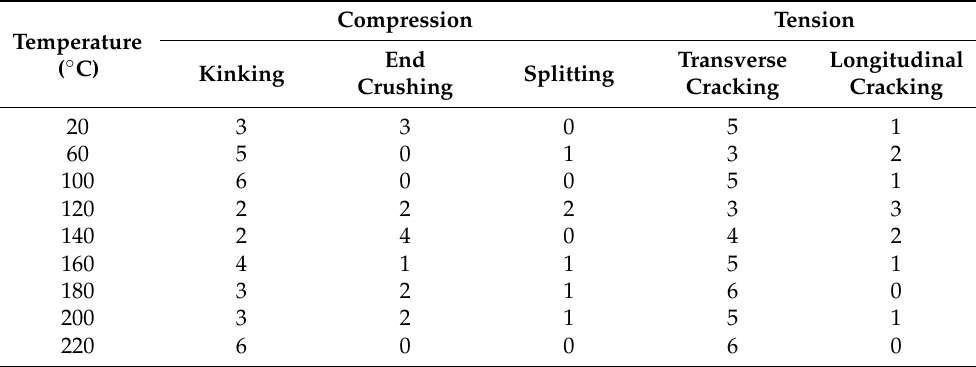
17% 100%17% 17% Figure 5. Percentages of the failure modes of the specimens under (a) tension and (b) compression. 83% 60% 83% 50% 67% 83% 100% 83% 40% 50% 33%